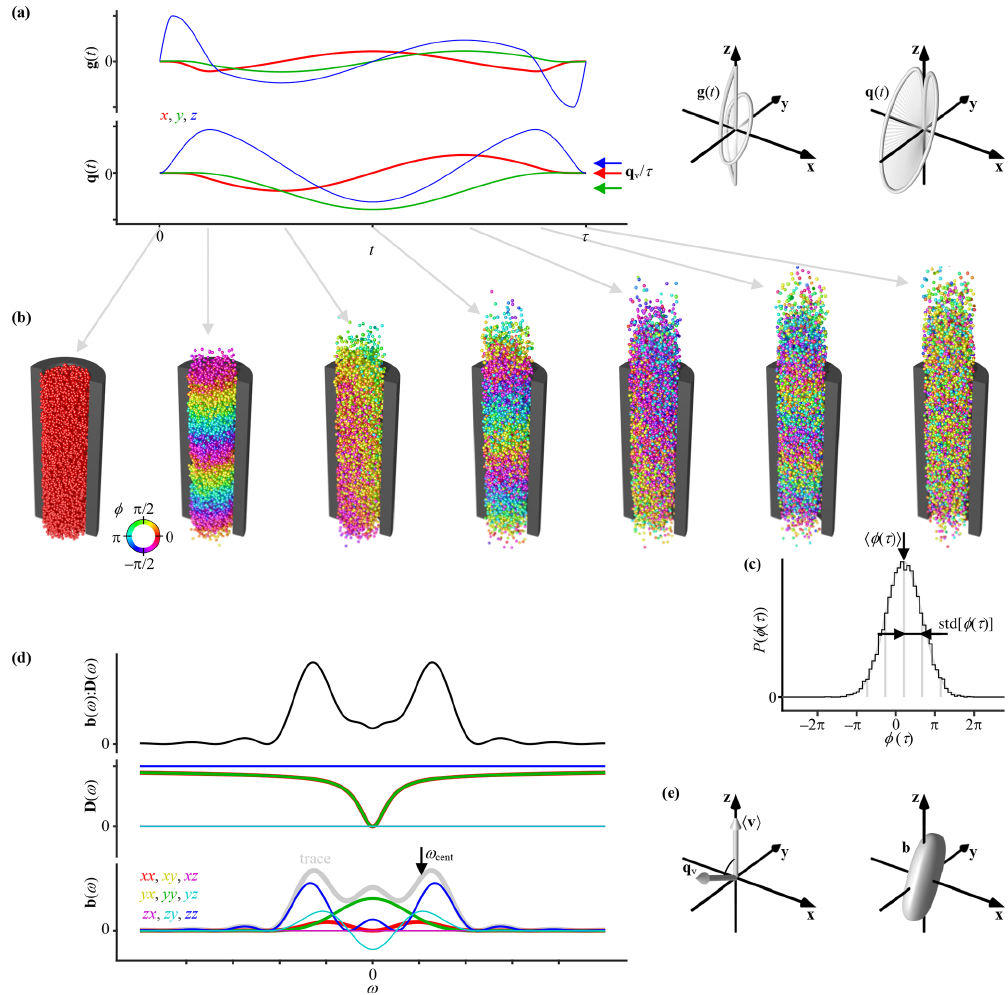
Figure 1. Principles of motion encoding by general gradient waveforms. (a) Time-dependent gradient g ( t ) and dephasing vector q ( t ) il- lustrated as 2D graphs of Cartesian components vs. t (left) and 3D plots of trajectories through space (right). The average values of the q ( t ) components within the time interval from t = 0 to τ are indicated with arrows labeled q v /τ , where the velocity-encoding vector q v is defined in Eq. (15). (b) Sequence of snapshots from a random walk simulation of an ensemble of spins (spheres) undergoing restricted diffusion and flow within an infinite cylinder (black section) during application of the waveforms in panel (a). Each spin is color-coded by its time-dependent phase φ ( t ) given by the interplay between g ( t ) and the spin positions r ( t ) according to Eq. (2). (c) Phase distribution P ( φ ( τ )) for the ensemble of spins at t = τ (black histogram) and a Gaussian (smooth gray line) with mean (cid:104) φ ( τ ) (cid:105) and standard deviation std[ φ ( τ )] (spacing between vertical gray lines) which give the phase shift α and attenuation factor β of the signal E ( τ ) via Eqs. (8), (9), and (11). (d) Frequency-dependent elements (color-coded) of the tensor-valued encoding spectrum b ( ω ) and diffusion spectrum D ( ω ) as well as their tensor dot product b ( ω ): D ( ω ) which gives β via Eq. (21). The centroid frequency ω cent (arrow) is obtained from the trace of b ( ω ) (gray line) via Eq. (32). (e) The 3D plots of the ensemble mean velocity (cid:104) v (cid:105) , velocity-encoding vector q v , and encoding tensor b , with the latter being defined in Eq. (33). The scalar product of (cid:104) v (cid:105) and q v gives α via Eq.